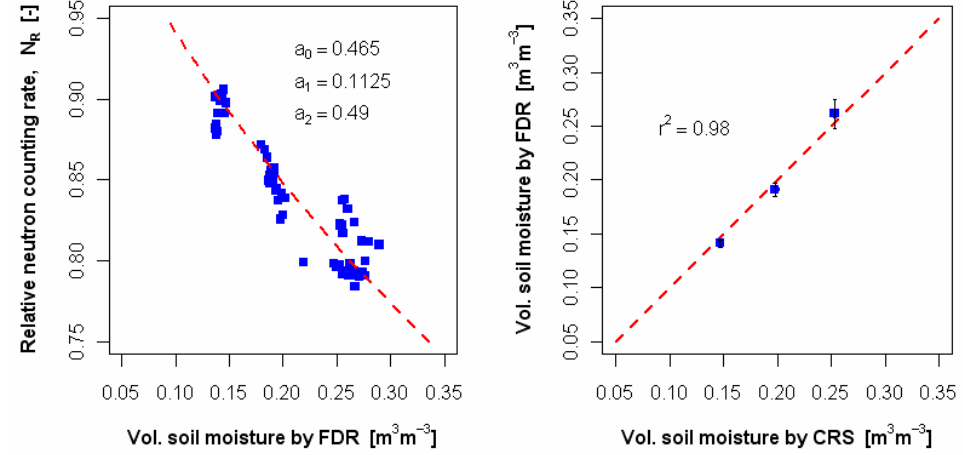
Fig. 6. Calibration of the CRS-1000: (left) calibrated function of soil moisture estimation by ground albedo neutrons (Eq. 1) and (right) correlation between soil moisture measured by CRS-1000 and measured by MR2 probes, where each data point represents the mean value of each calibration period.